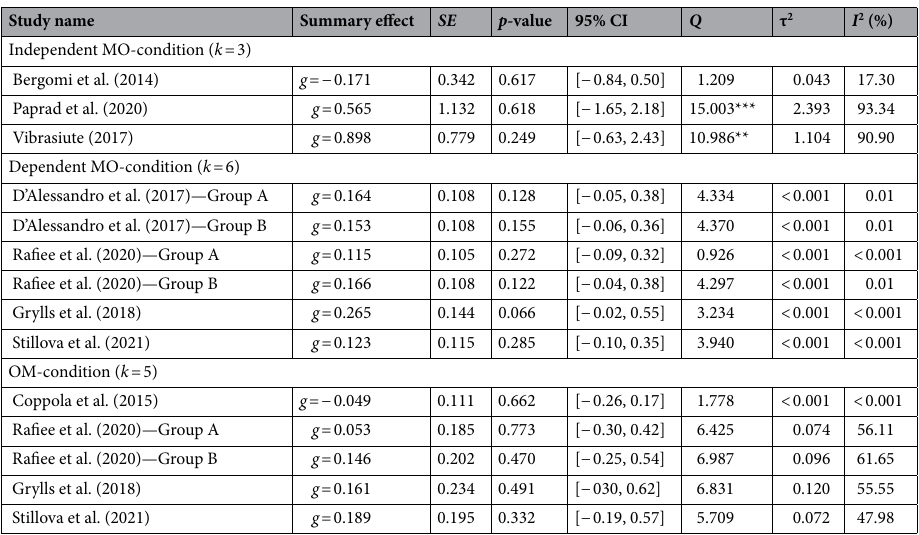
Table 4. Leave-one-out sensitivity analyses showing summary effects when respective studies were removed from analyses. k = number of effect sizes included in the respective condition; SE = standard error; 95% CI = 95% lower and upper bound of 95% confidence interval; Q = Cochran’s Q test statistic for heterogeneity; τ 2 = between-studies variance; I 2 = ratio between true heterogeneity and total observed variation; ** p < 0.01; *** p < 0.001.